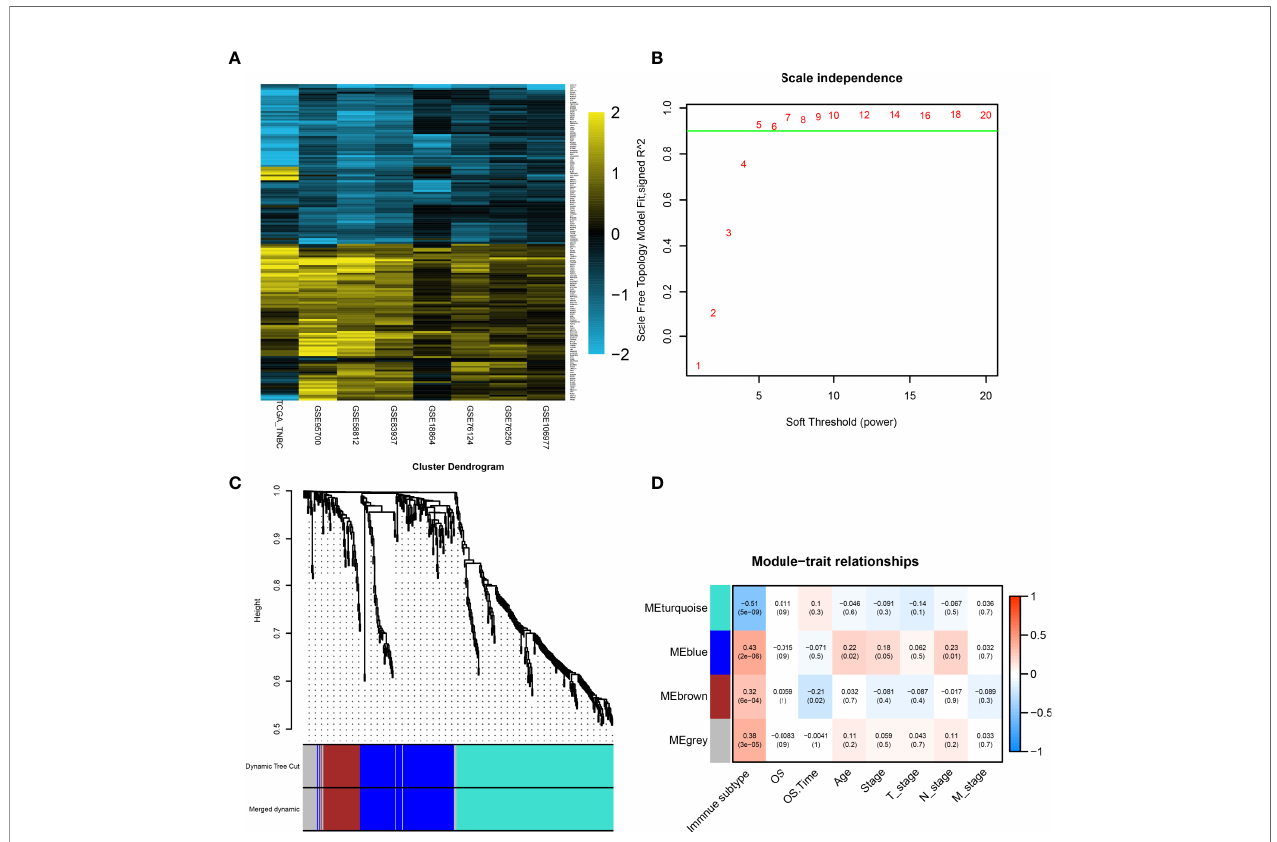
FIGURE 4 | Identi fi cation of hub genes by RRA analysis and WGCNA. (A) Heatmap showing the top 100 upregulated genes or downregulated genes according to log2 fold change value. Each row represents one gene and each column indicates one dataset. Gold indicates upregulated genes and blue represents downregulated genes in subtype2. (B) Analysis of the scale-free fi t index for various soft-thresholding powers ( b ). In all, 5 was the fi ttest power value. (C) The cluster dendrogram of TCGA-TNBC patients. Each branch in the fi gure represents one gene, and every color below represents one coexpression module. (D) PCC matrix between gene module and clinical characteristics. The PCC values range from − 1 to 1 depending on the strength of the relationship. A positive value indicates that the genes within a particular coexpression module increase as the clinical trait increases. DEG, differentially expressed gene; RRA, robust rank aggregation; WGCNA, weighted gene coexpression network analysis; PCC, Pearson correlation coef fi